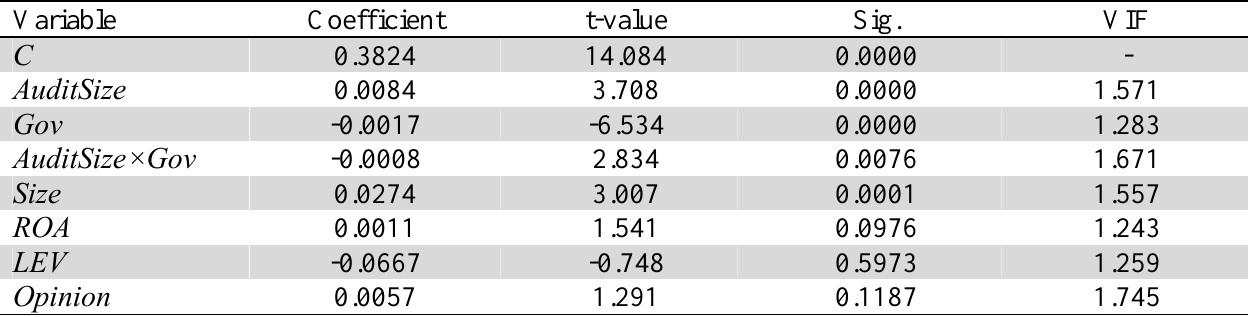
The summary of testing the third hypothesis Variable Coefficient t-value Sig.